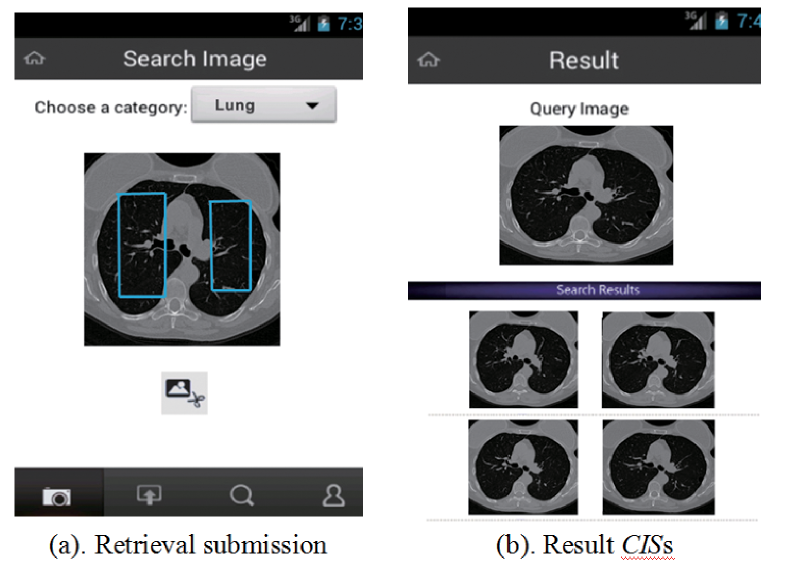
Fig 10. A prototype system of the BRS